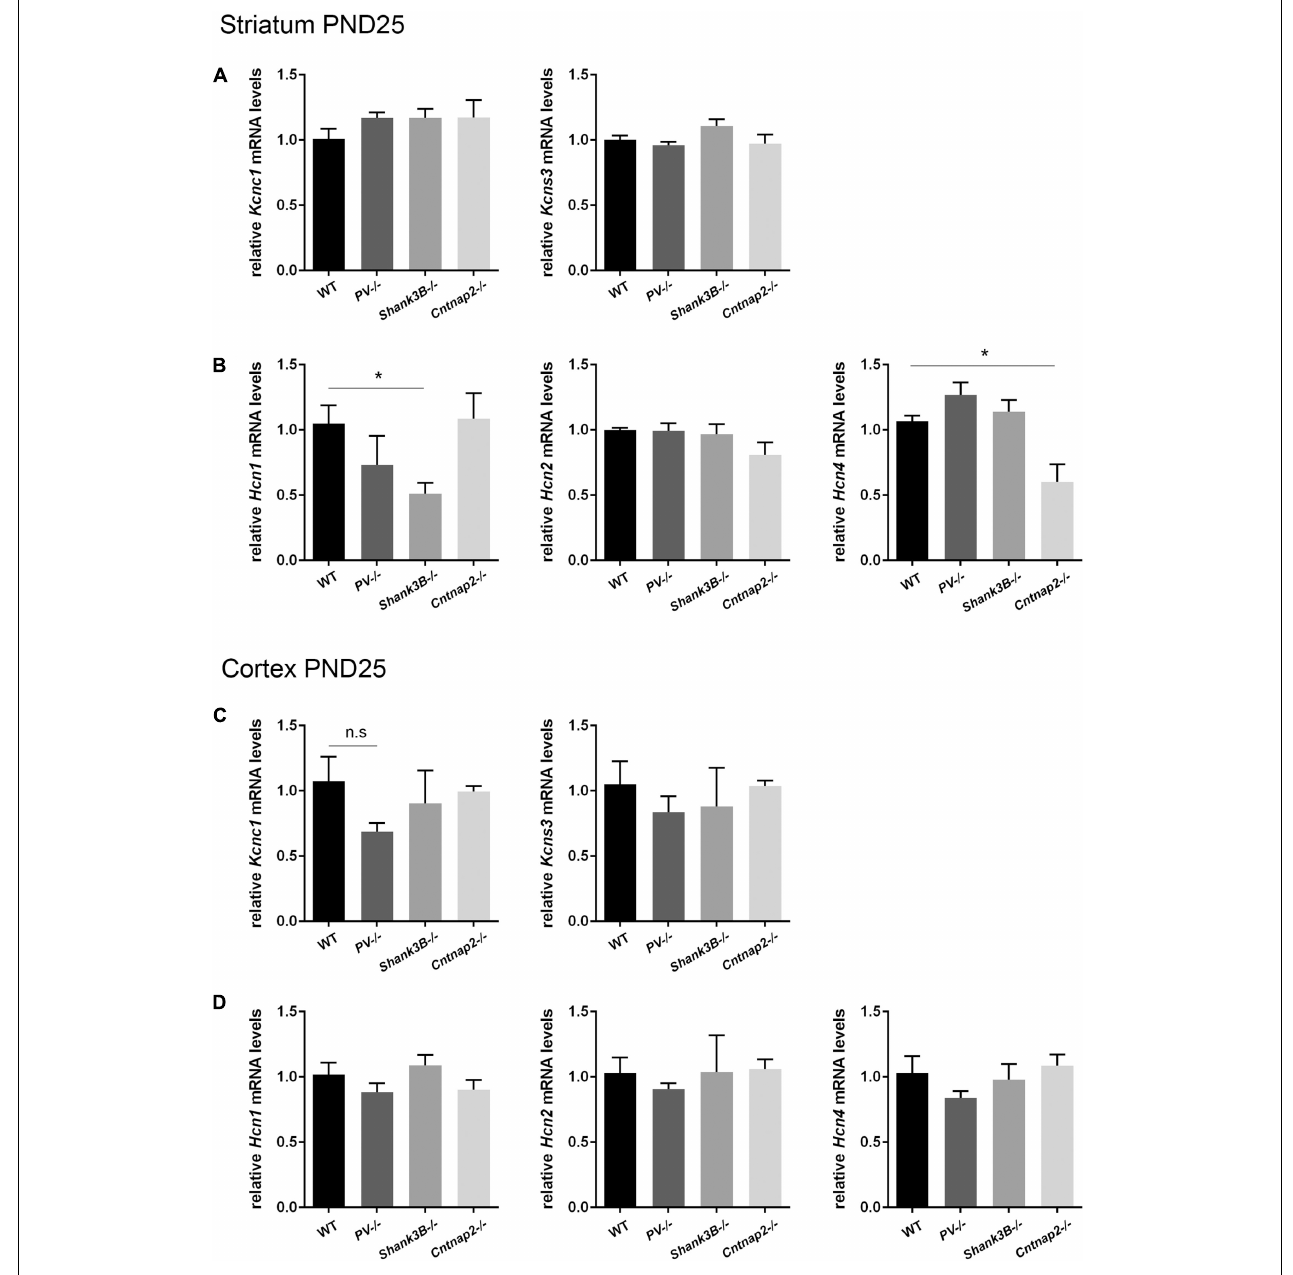
FIGURE 6 | RT-qPCR values from striatal and cortical samples of WT, PV–/–, Shank3B–/–, and Cntnap2–/– PND25 mice representing mRNA levels for (A) and (C) Left: Kcnc1 ; Right: Kcns3 , (B) and (D) Left: Hcn1 ; Middle: Hcn2 ; Right: Hcn4 . Signals were normalized to Gapdh (striatum) or Rn18S (cortex) mRNA levels and expressed as fold change compared to WT ( N = 5 mice each). All data are expressed as mean ±